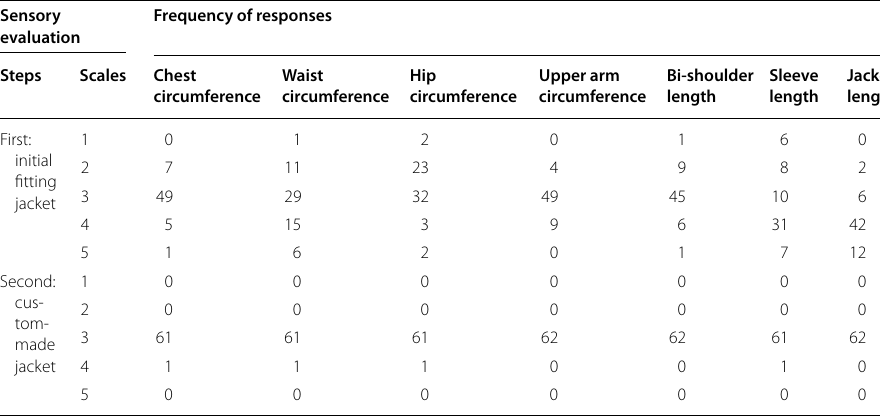
Table 3 Frequency of responses by scales of sensory evaluations Sensory